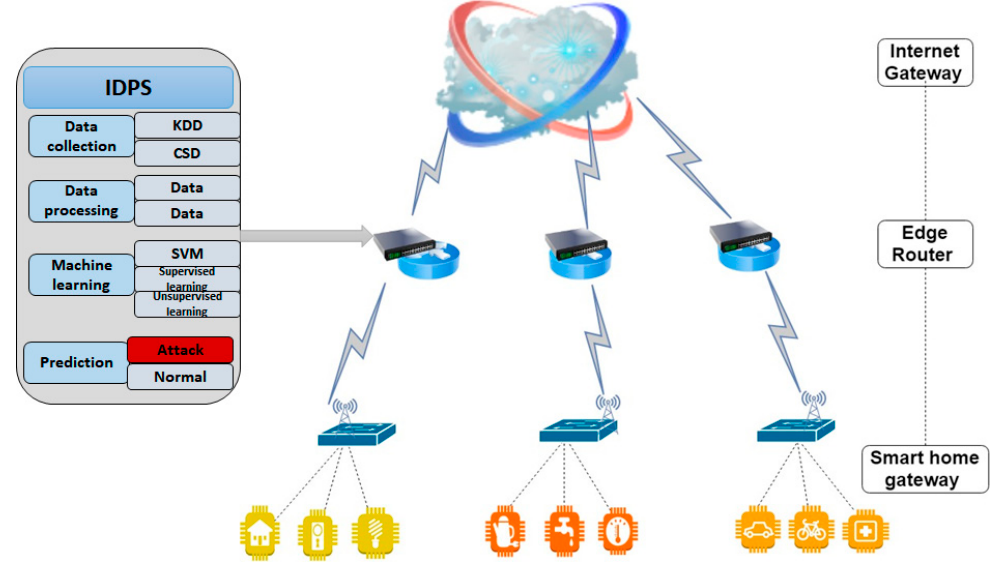
Figure 6. Smart home architecture with IDPS-based machine learning .